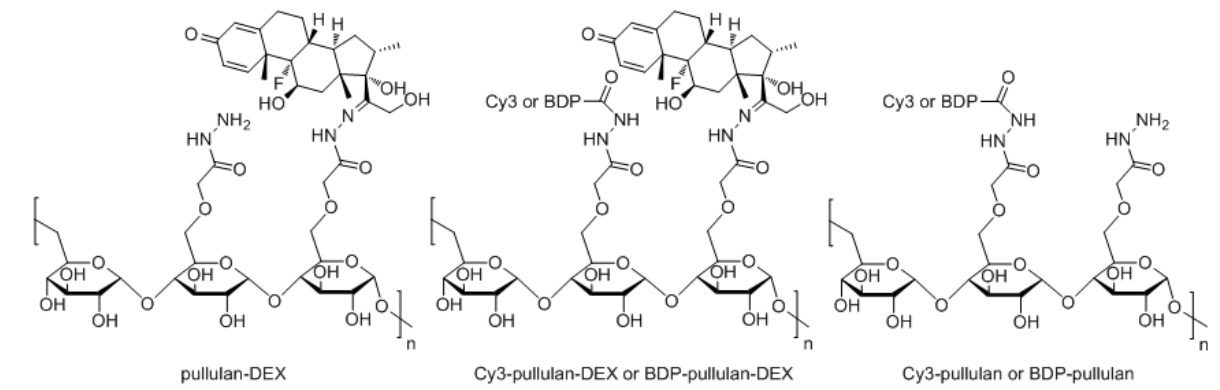
Figure 1. Chemical structures of fluorescently labelled pullulan conjugates. Synthetic details can be found in a recent publication [26] and in Supporting Information SI-1.